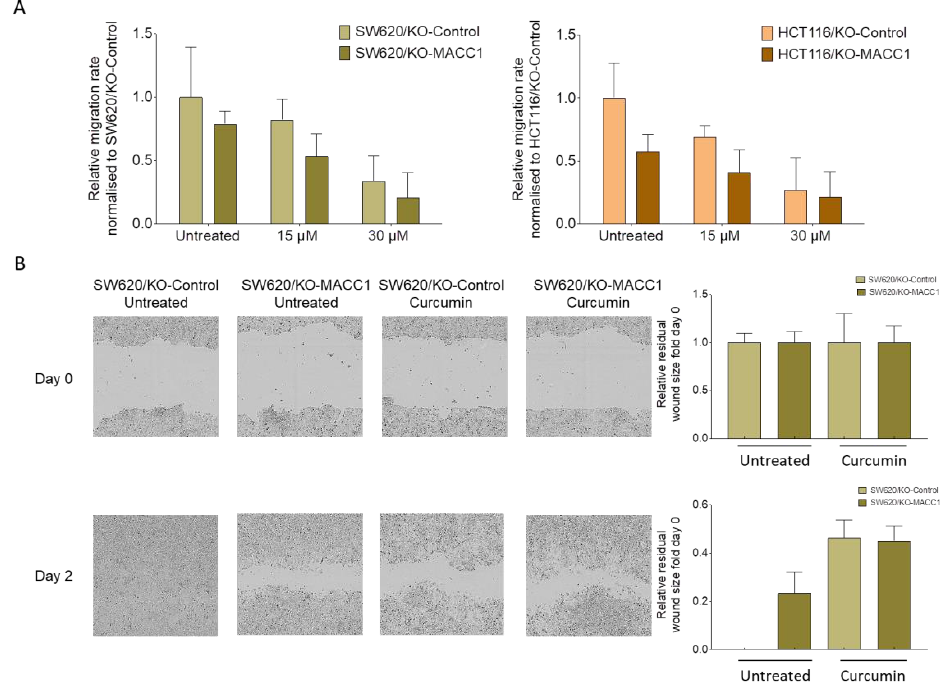
Figure 3. Curcumin reduced the cell motility in CRC cell lines with high or moderate MACC1 expression. SW620 and HCT116 cells were treated with 15 µ M and 30 µ M curcumin, and their impact on the migratory capability was measured by Boyden chamber assay ( A ). The results were further validated by a wound healing assay, and wound size was analyzed and visualized by the IncuCyte live cell imaging system ( B ). Data represent mean ± SEM ( n ≥ 3).